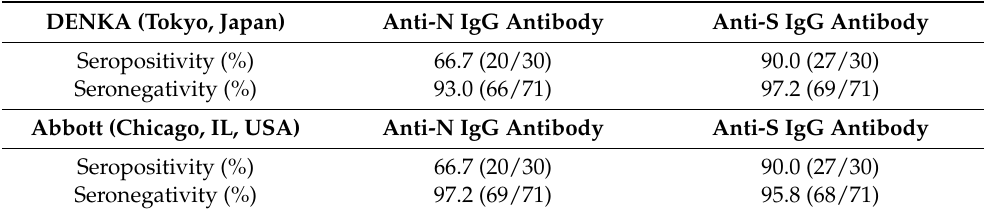
Table 2. Test seropositivity and seronegativity of the DENKA and Abbott methods for anti-N and anti-S IgG antibodies among patients with COVID-19 at the nursing home in Niigata, Japan in April 2021 ( n =